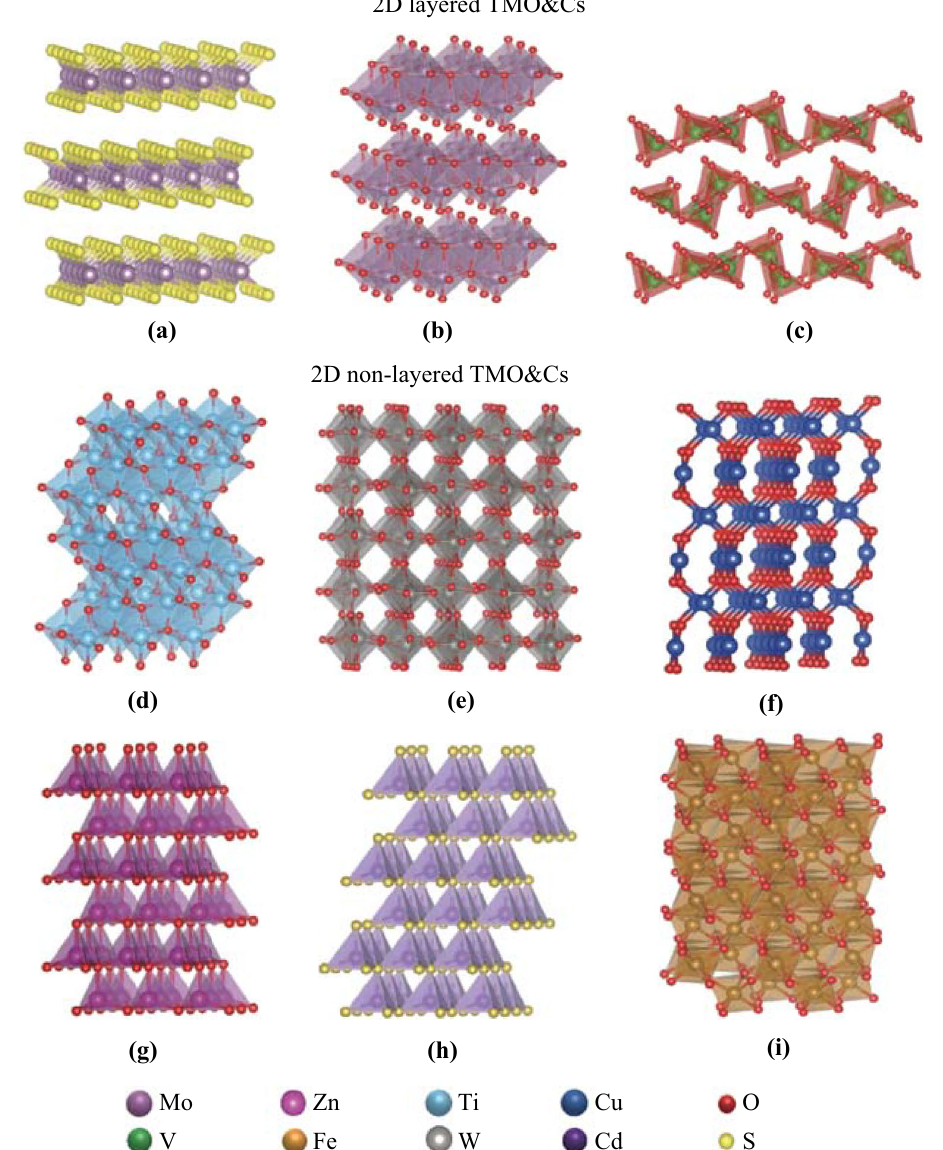
Fig. 2 Crystal Structure of a hexagonal 2H MoS 2 , b orthorhombic MoO 3 , c orthorhombic V 2 O 5 , d anatase TiO 2 , e monoclinic WO 3 , f monoclinic CuO, g wurtzite ZnO, h wurtzite CdS, and i rhombohedral Fe 2 O